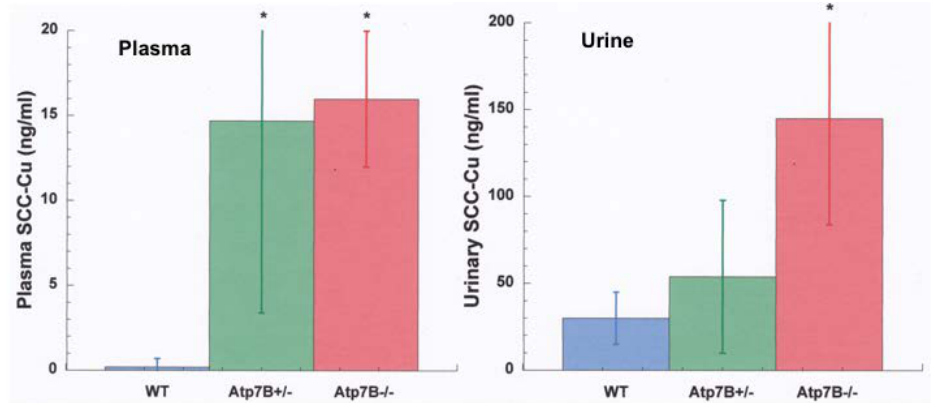
Figure 8. Levels of Cu associated with the small copper carrier (SCC) in the plasma (left) and urine (right) of Labrador retrievers that do and do not have defects in Atp7B, relative to the wild type. Values are for ng/mL Cu in 3 kDa ultrafiltrates (Means + SD) for blood plasma (left) and urine (right) of wild type controls (blue), and for retrievers with hetero (green) and homozygous (red) defects in Atp7b (5–6 animals/group). Pooled ultrafiltrate samples eluted as a single peak of ~1.7 kDa by size exclusion chromatography from a small pore gel column (Superdex 30 Increase) (not shown). From Sai Vallabhaneni, Kaitlynne Kim, Maria C. Linder and Hille Fieten, unpublished. * p < 0.01 vs. WT.